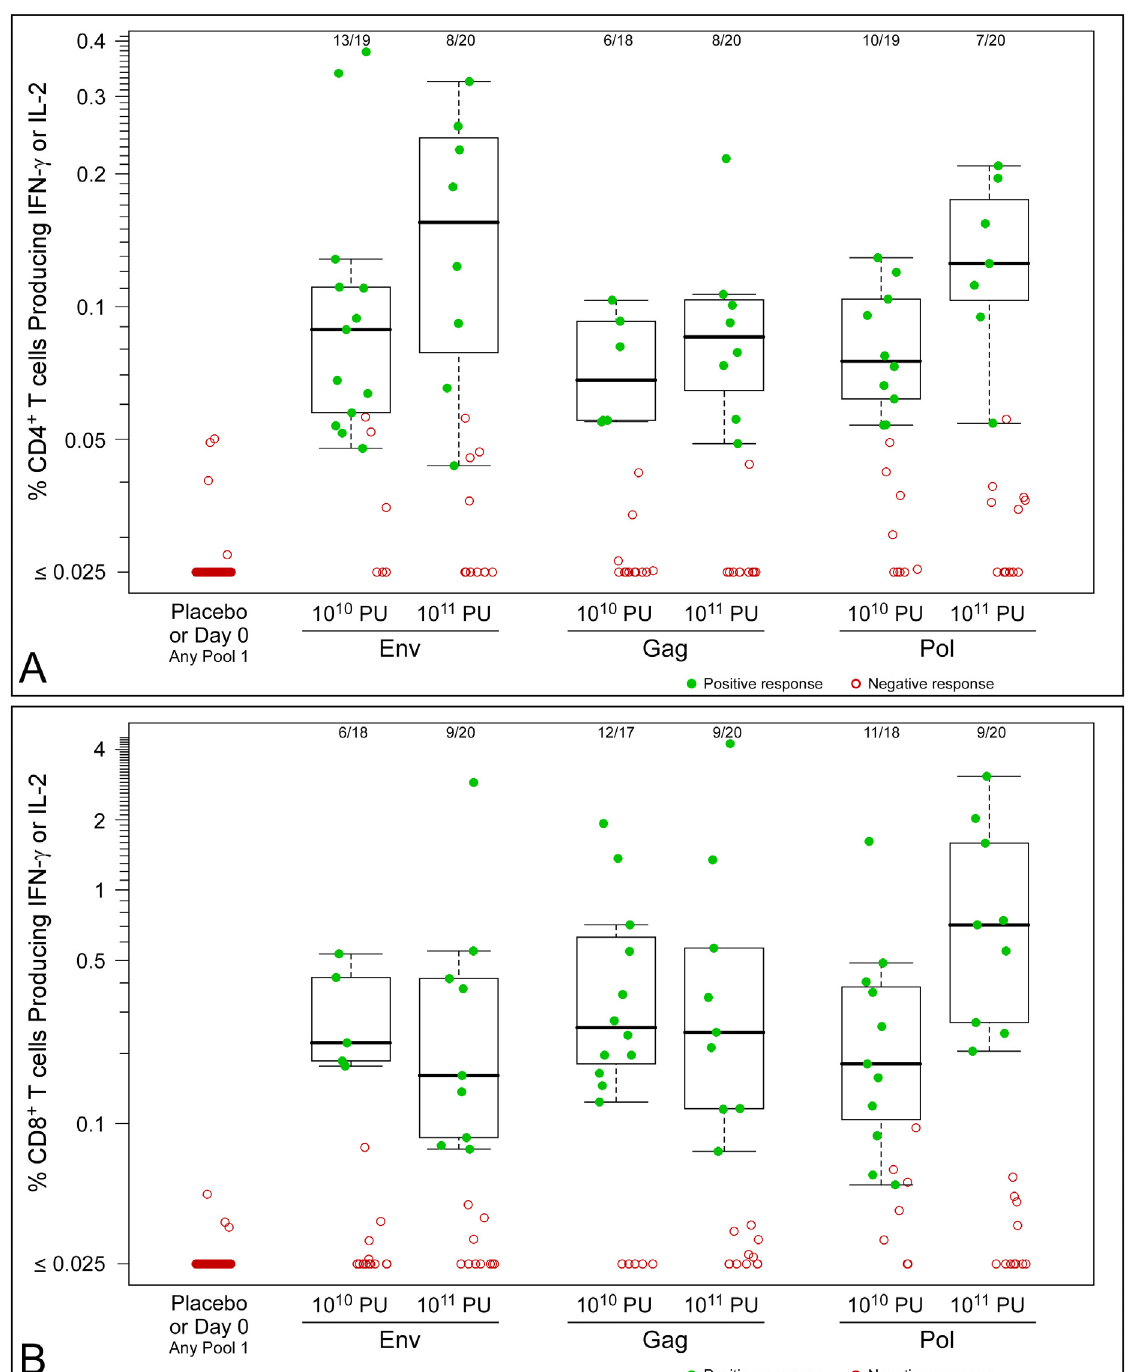
Figure 7. Magnitudes of responses by ICS to pool 1 peptides at day 28 following study injection. A) CD4 + T cell responses. B) CD8 + T cell responses. The box plots are based only on the positive responses. The box indicates the median and interquartile range (IQR); whiskers extend to the furthest point within 1.5 times the IQR from the upper or lower quartile. The number of vaccinees with a positive response out of the total number of vaccinees tested is indicated above the bars.